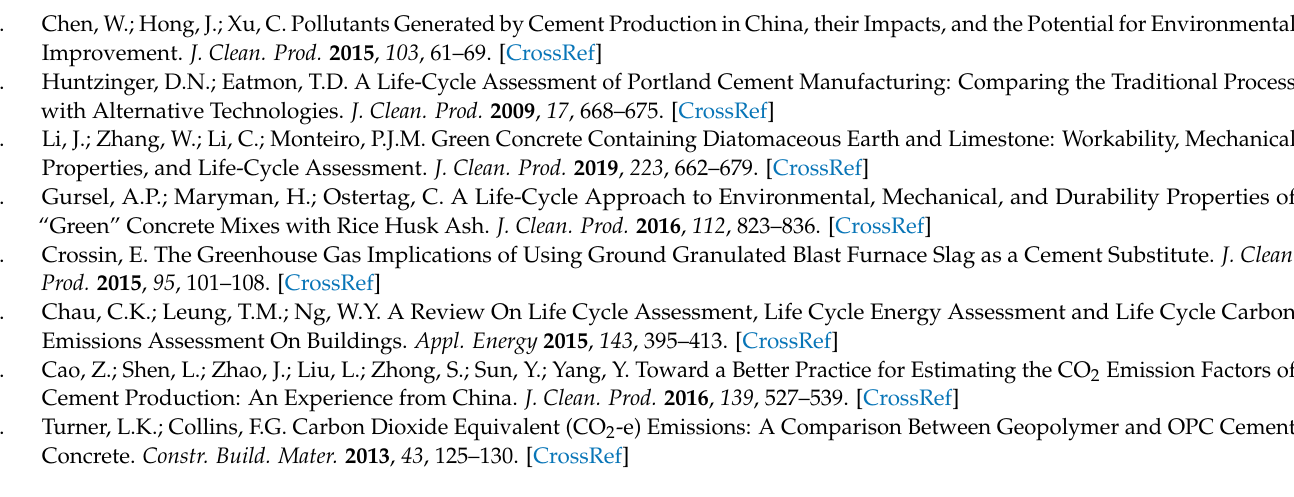
grades (kg/m 3 ), Table S4: Mix proportion of OPC concrete under different strength